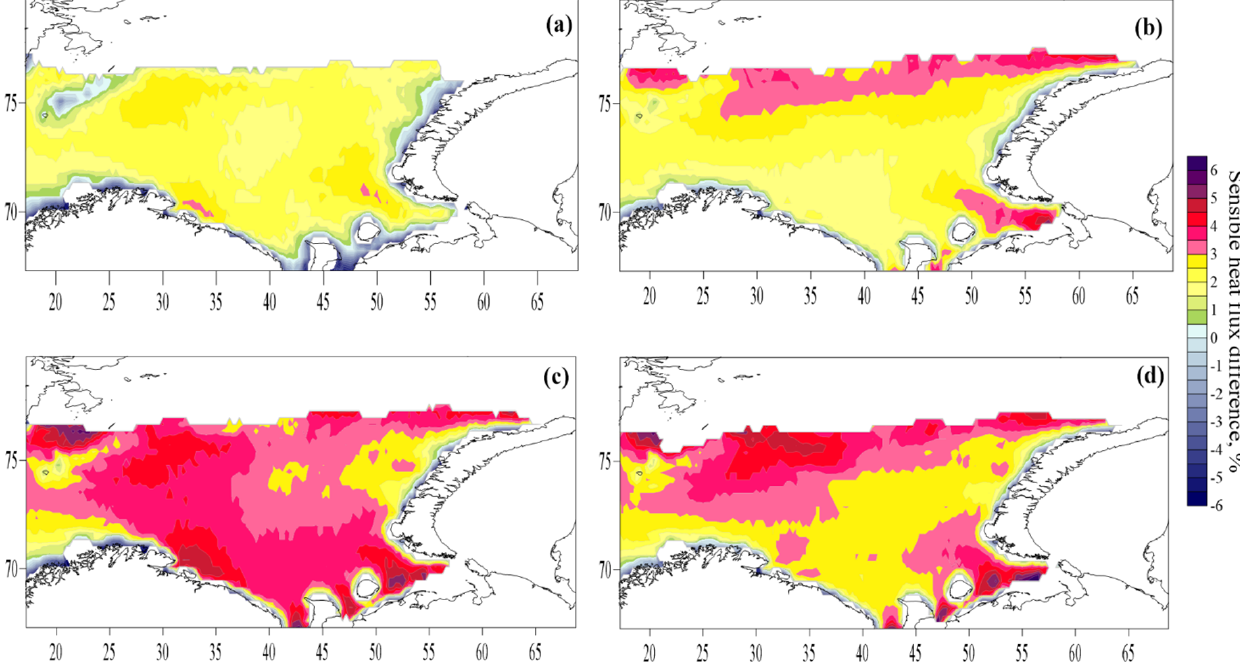
Figure 21. Mean relative difference in sensible heat flux (%) in the T1–C55 experiments for all cases (a) , during cold-air outbreaks (b) , during storms (c) , and during simultaneously observed storm wave events and cold-air outbreaks (d)